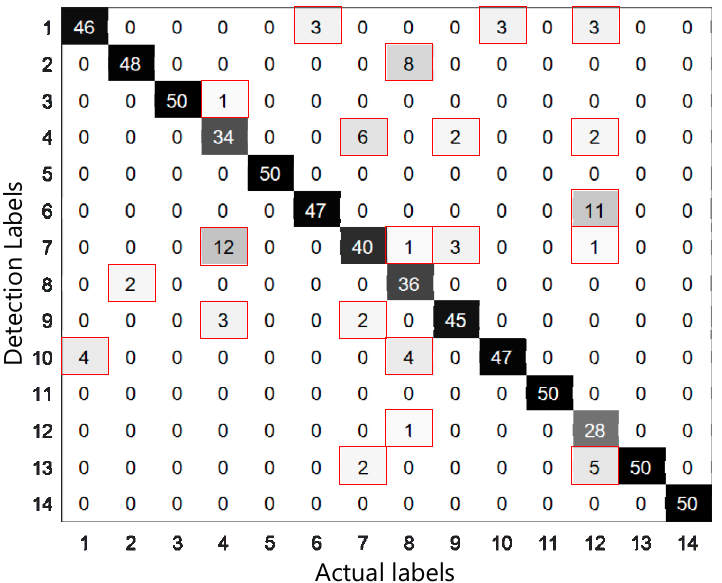
Figure 15. The confusion matrix of the test data (BPNN).